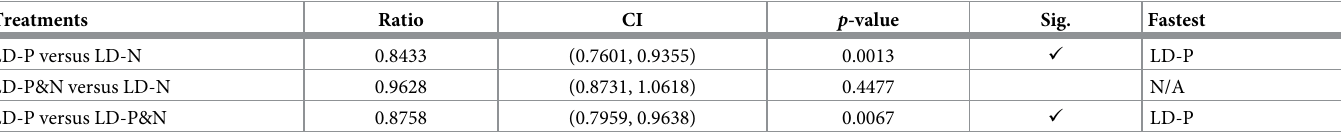
Table 14. LD : Intersection cardinality time analysis.